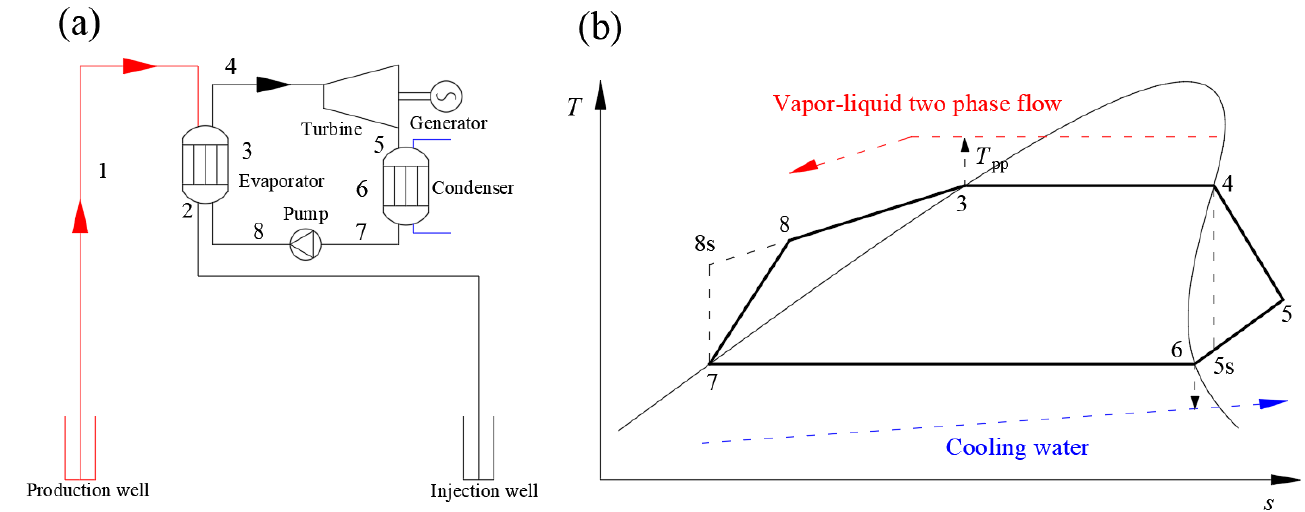
Figure 2. The schematic diagram and T-s diagram of the ORC system. ( a ) schematic diagram; ( b ) T-s diagram.